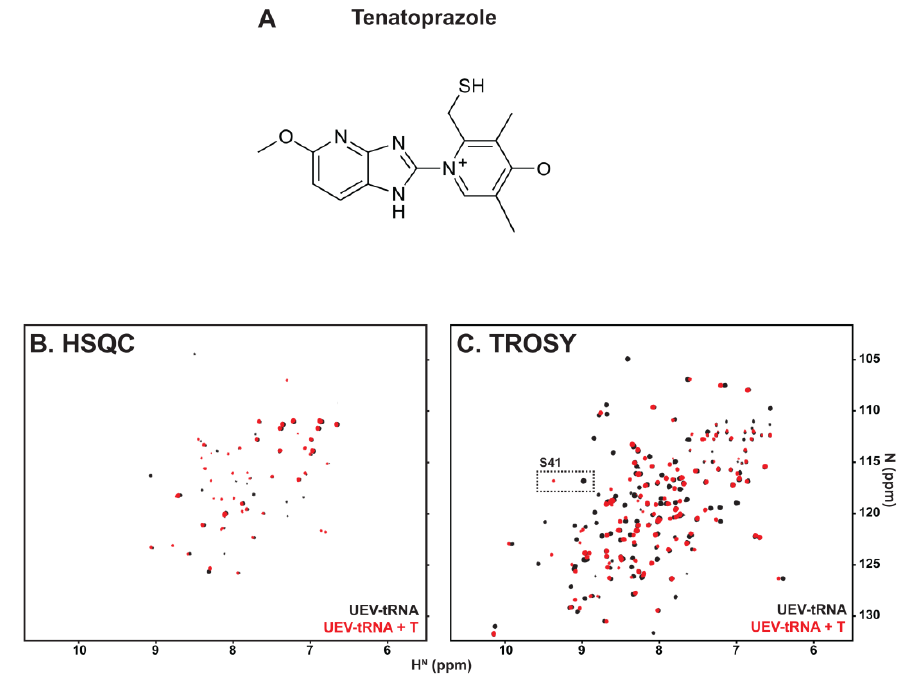
Figure 3. tRNA binding does not prevent access to sites necessary for Ub binding. ( A ), Chemical structure of active tenatoprazole (T) compound that targets Cys73 in the Tsg101 UEV domain [32]. ( B ), ( C ), Overlay of the HSQC spectra ( B ) or TROSY spectra ( C ) of the UEV-tRNA complex captured in the absence (black) or presence (red) of T.